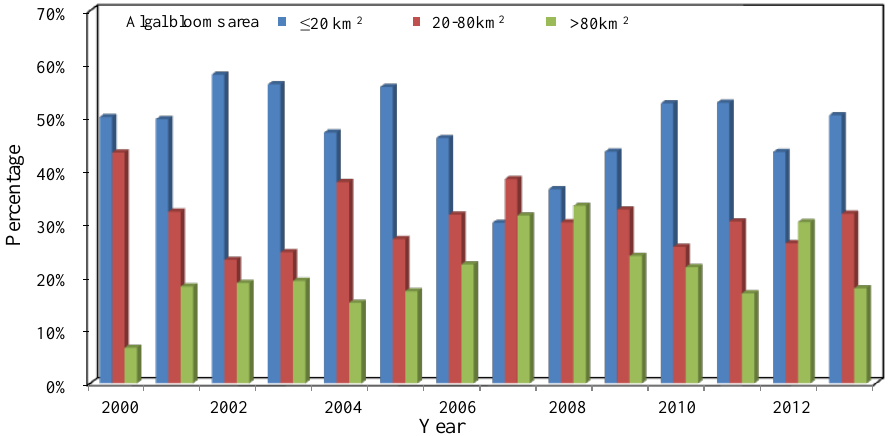
Figure 3. The percentage of days with different algal bloom areas in Lake Chaohu from 2000 to 2013, 80 km 2 and 20 km 2 lake algal bloom coverage, equivalent to 10% and 2.5% of the total area of Lake Chaohu, respectively. Table 3. Timing in Julian days and duration of significant floating algae blooms in each lake segment of Lake Chaohu * .